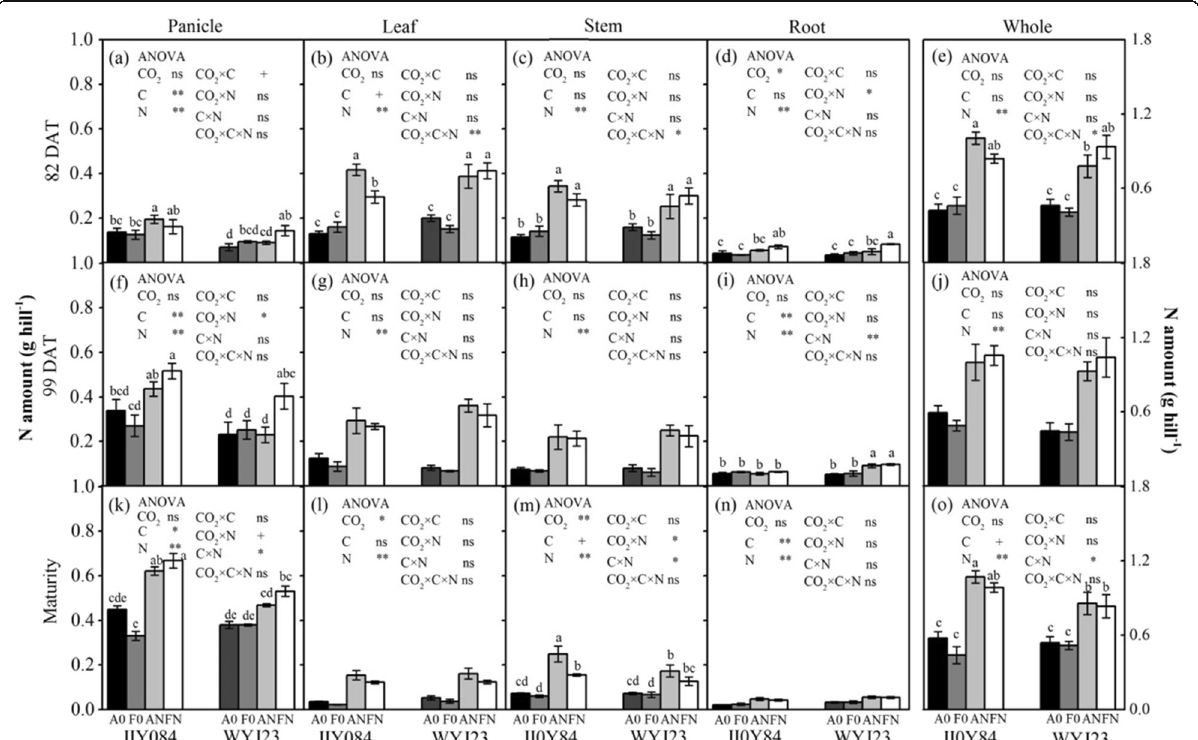
Fig. 2 The N amounts in four tissues and the whole plants of two cultivars (IIY084 and WYJ23) subjected to ambient (A) and elevated [CO 2 ] (F) at none (0N) and normal N levels (NN) at three stages and the results of three-way ANOVA (type III) (different letters represent significant differences in each tissue among eight treatments at each sampling date according to LSD at 5%